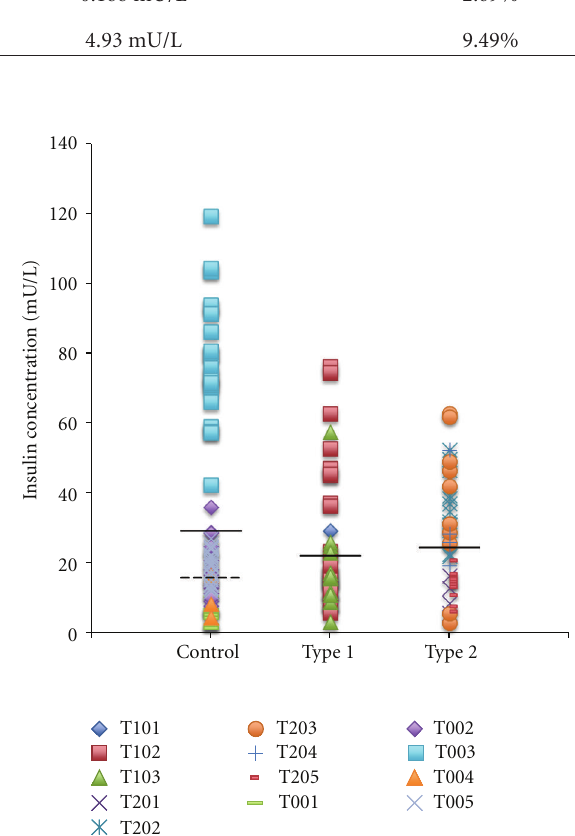
Figure 2: Total Insulin content of each milk sample (fore and hind milk) collected for all mothers as measured by the CMIA method. Dark lines indicate the mean for each group. The dotted line indicates the mean for the control group with the outlier mother T0-03